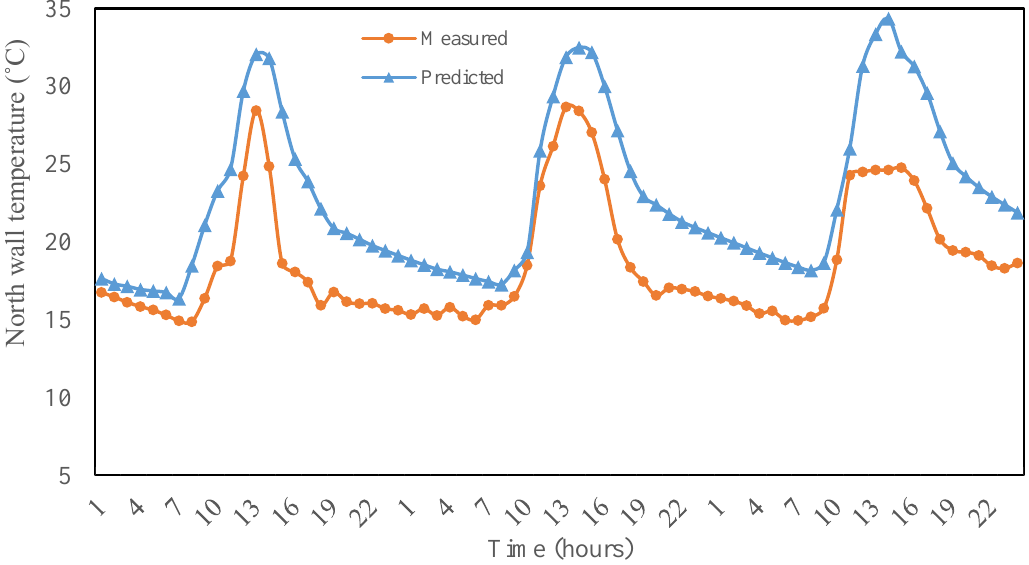
Figure 8. The comparison of measured and predicted temperature of the north wall surface.